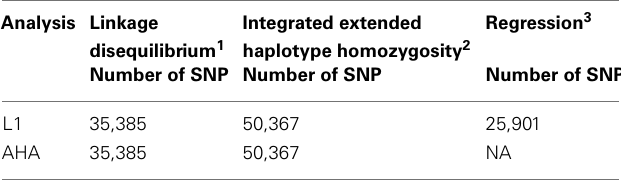
Table 1 | Number (n) of SNP used to estimate linkage disequilibrium (LD), integrated extended haplotype homozygosity, and for regression of allele frequency on cumulative selection differential in Line 1 Hereford (L1) and the general Hereford population